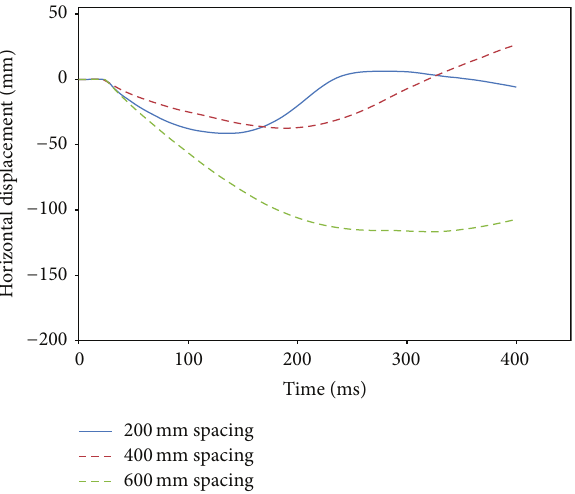
Figure 11: Final vertical displacements along thelength of reinforce- ment for each reinforcement spacing (200, 400, and 600